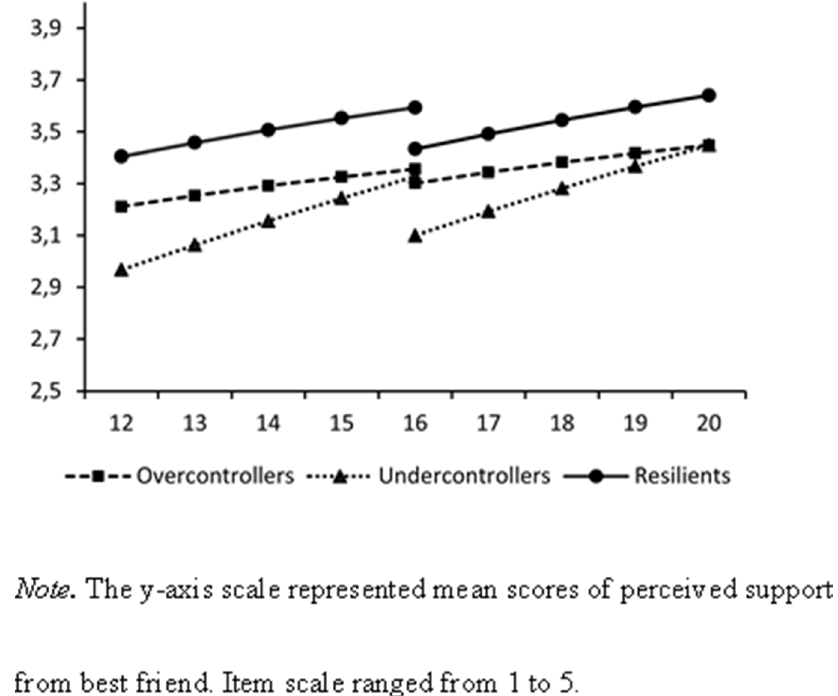
Figure 2. Estimated Developmental Changes in Adolescent Friendship Support by Adolescent Personality Types.